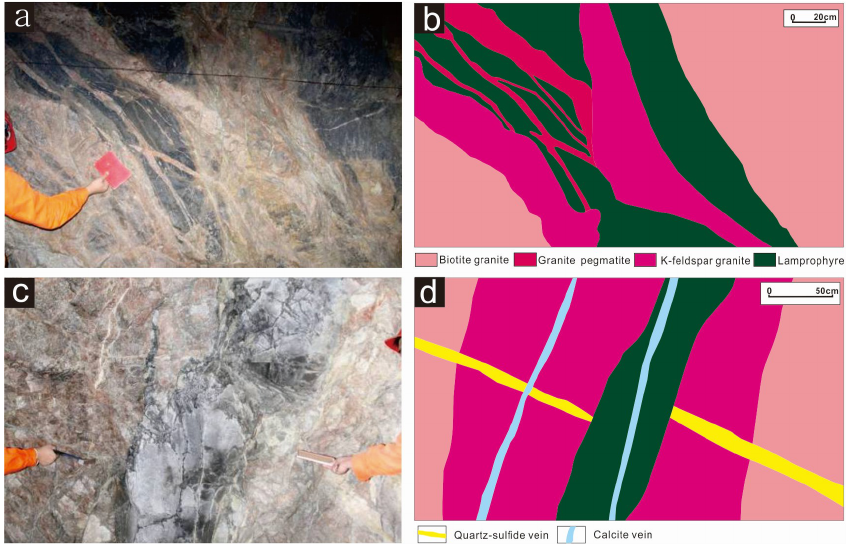
Figure 5. Field photographs showing the crosscutting relationships of the major geologic bodies from the Sizhuang gold deposit: ( a , b ) The K-feldspar altered granite crosscuts the biotite granite and ( c , d ) the quartz-sulfide vein crosscuts the K-feldspar altered granite, and the calcite vein crosscuts the quartz-sulfide